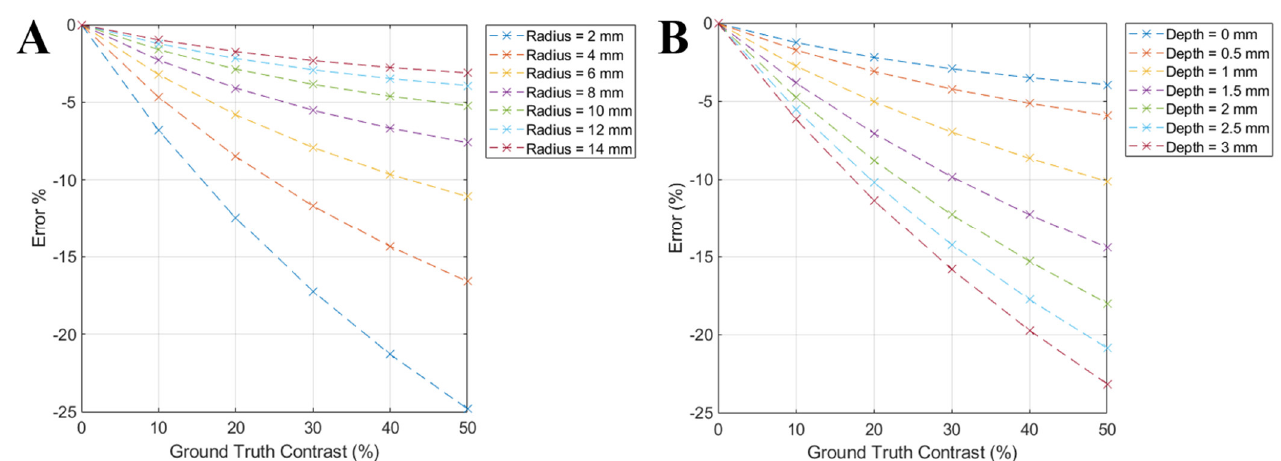
Figure 7. Single anomaly simulations. ( A ) Recovery errors for a centrally located anomaly of varying radii, with a range of absorption values simulated. ( B ) Recovery errors for a centrally located anomaly of varying depths, with the same range of absorption values simulated. The recovery errors are determined using Equation (8).